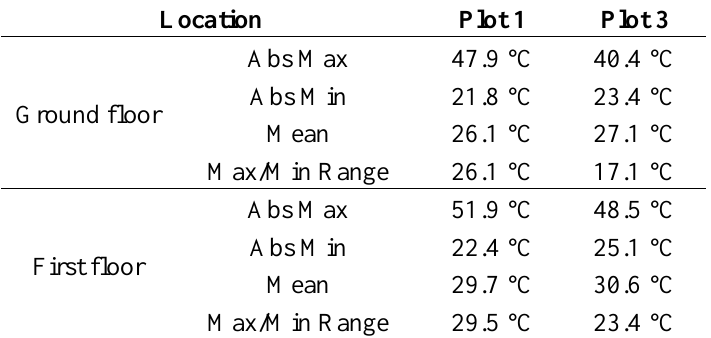
Table 8. Comparison of Plots 1 and 3 sunspace mean, maximum and minimum temperature values at two altitudes.